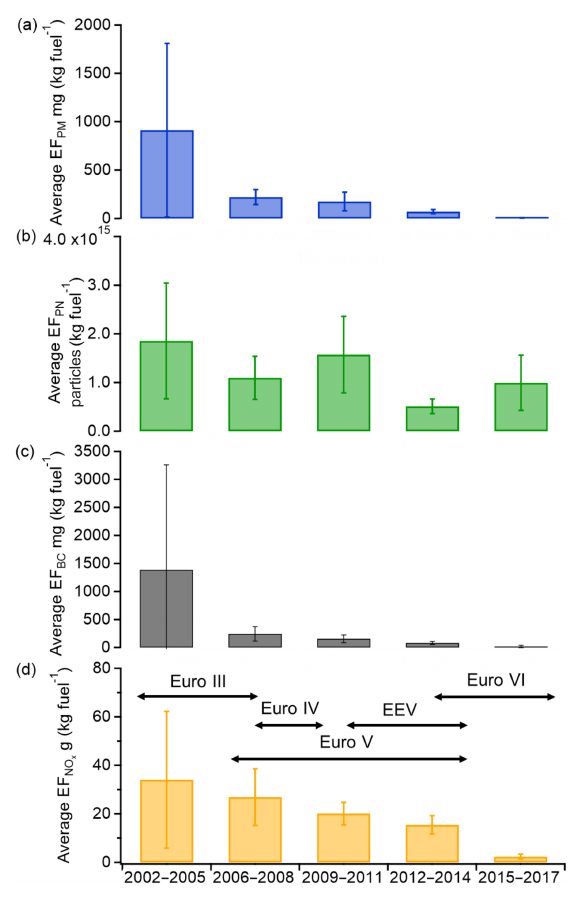
Figure 6. The average EFs of (a) PM, (b) PN, (c) BC, and (d) NO x with respect to the registration year of HDTs. Error bars represent the statistical 95% confidence interval. Black arrows mark the years that the particular type of HDT examined in this study was first